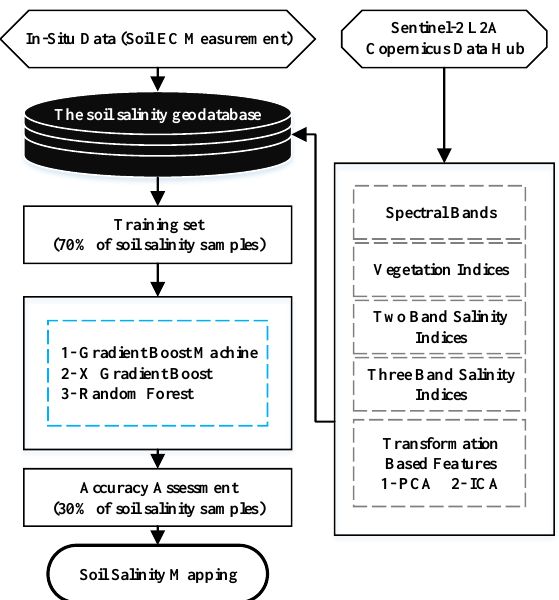
Figure 3. Flowchart of the proposed method for estimating the soil salinity in the Eshtehard Salt River area based on machine learning regression